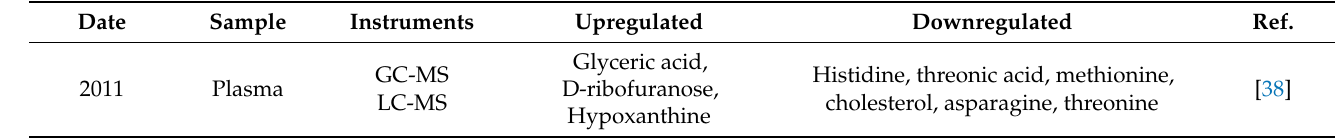
Table 1. Metabolic changes and related studies in patients with rheumatoid arthritis